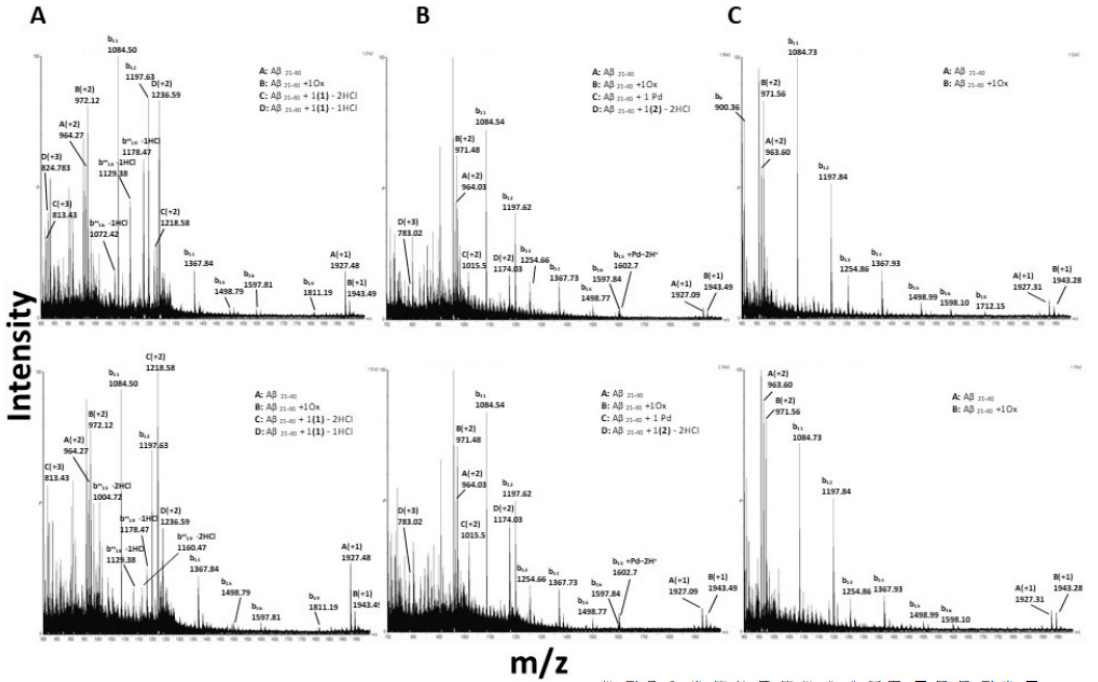
Figure 6. ESI-MS spectra of A β 21–40 incubated with: ( A ) 1 , at t = 0 (upper panel) and t = 17 h (lower panel), ( B ) 2 , at t = 0 (upper panel) and t = 17 h (lower panel), ( C ) 3 , at t = 0 (upper panel) and t = 17 h (lower panel). In all panels, signals belonging to the fragmentation b series of A β 21–40 are indicated. b series fragmentation signals deriving from A β 21–40 complexed with metal compounds are indicated with an asterisk. Table 3. Results of the ESI-MS analysis of the adducts formed by the reaction of A β 21–40 with 1, 2 and 3. The experimental m/z values, the ion charge status, the experimental (Exp) and theoretical (Theor) monoisotopic mass values, the corresponding ion species and times of incubation are reported.